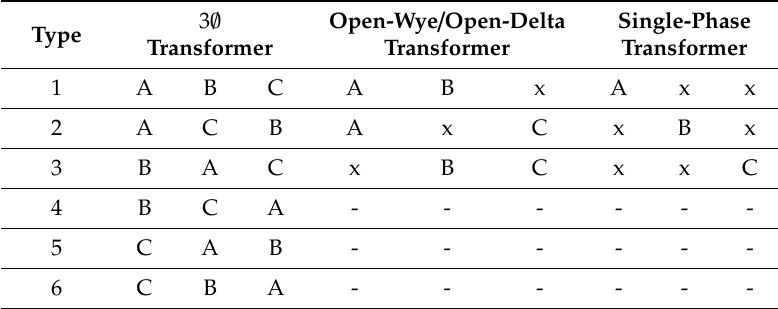
Table 1. The feasible connection schemes for